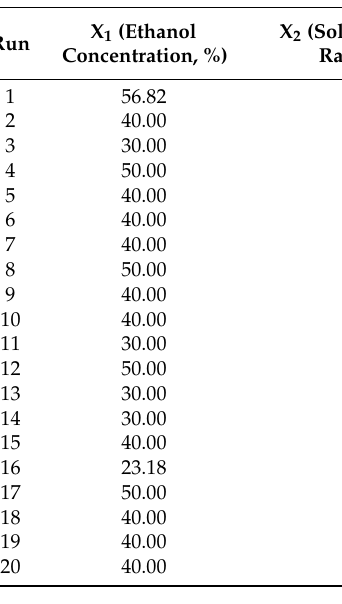
Table 1. The experimental design, experimental value, and predicted value of